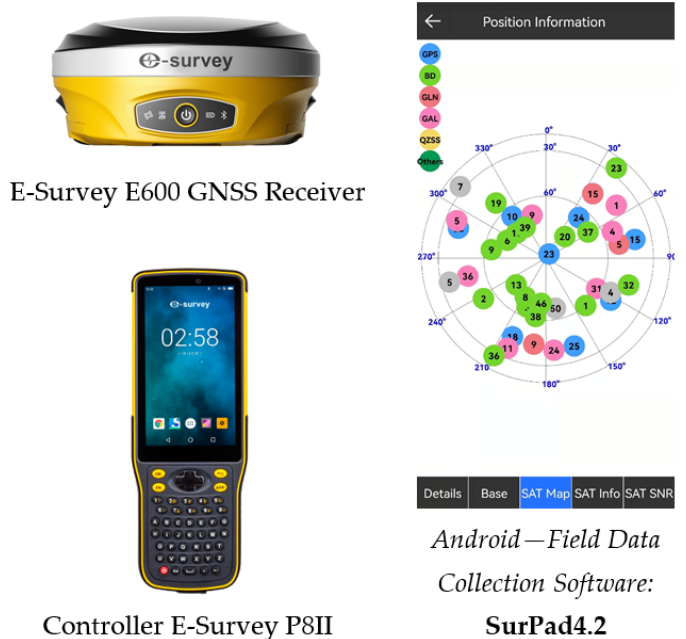
Figure 3. Measurement equipment.